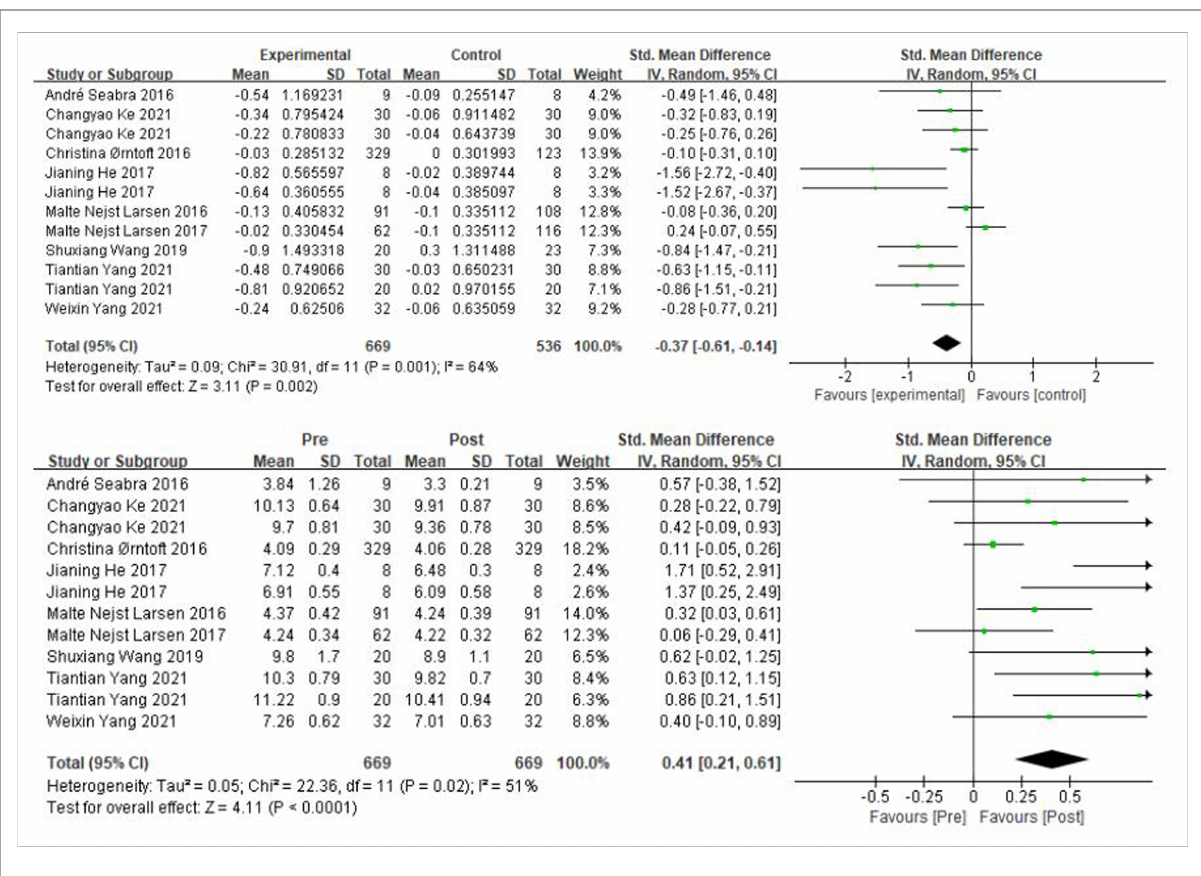
FIGURE 4 A meta-analysis of the results of linear sprint ability was conducted for comparisons between the control and experimental groups and for comparisons between the experimental groups pre- and